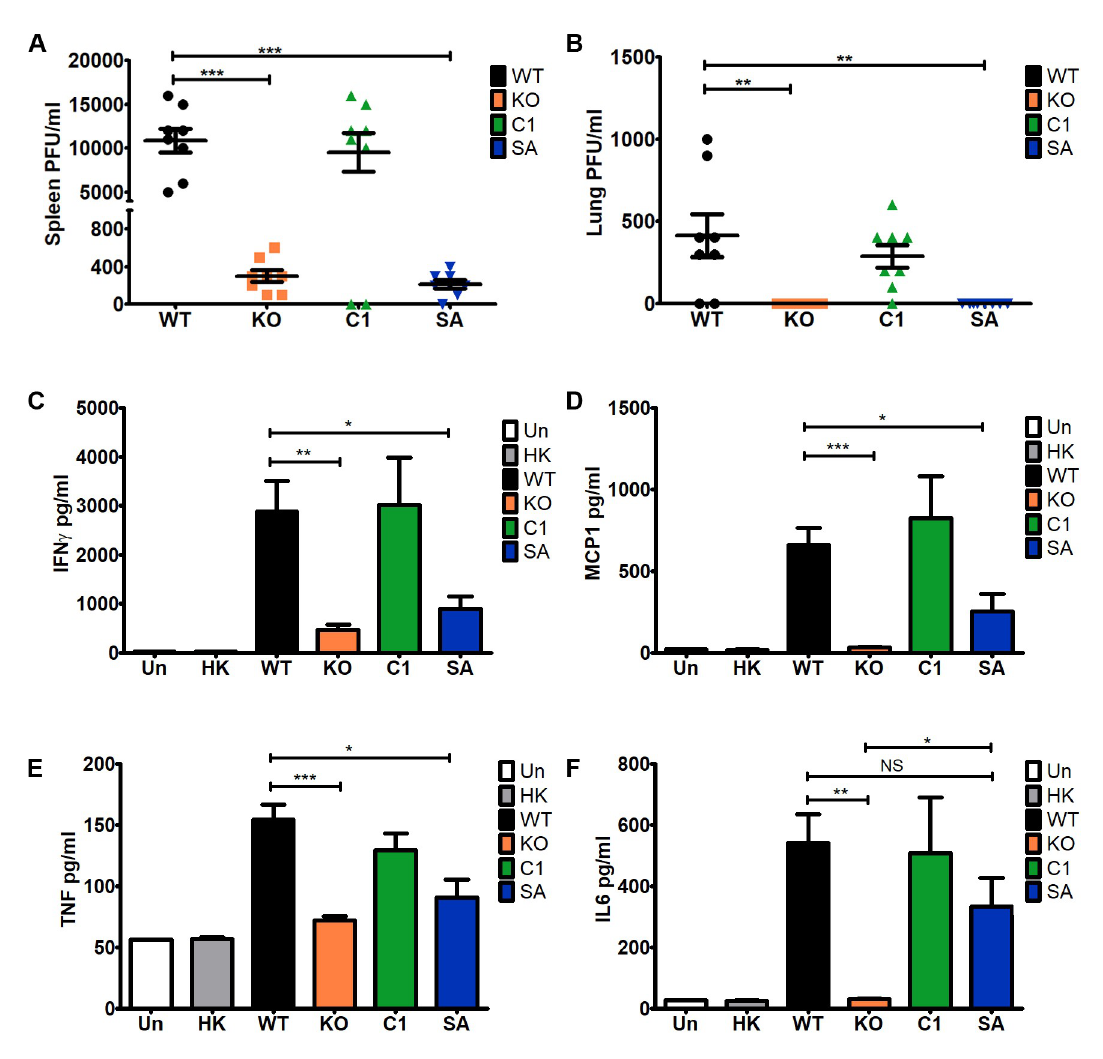
Fig 7. Δ TgPL3 and S1409 parasites are unable to disseminate in vivo . In 2 independent experiments, 4 male NMRI mice were infected with 1000 T . gondii parasites. 3 days post infection (A) spleens and (B) lungs were removed and homogenized. Homogenate was serially diluted, added to HFF monolayers in duplicate, and plaqued for 7 days. The monolayers were stained with crystal violet and PFU/ml calculated. (C-F) Serum was collected from the same mice at 3 days post infection and cytokine levels of (C) IFN γ , (D) MCP1, (E) TNF and (F) IL6 were determined using a cytokine bead array kit (Biosciences). Cytokine analysis was repeated with female mice and shown is one representative experiment. Uninfected mice and mice infected with 1000 heat-killed parasites were used as negative controls � p < 0.05, �� p < 0.01 and ��� p <